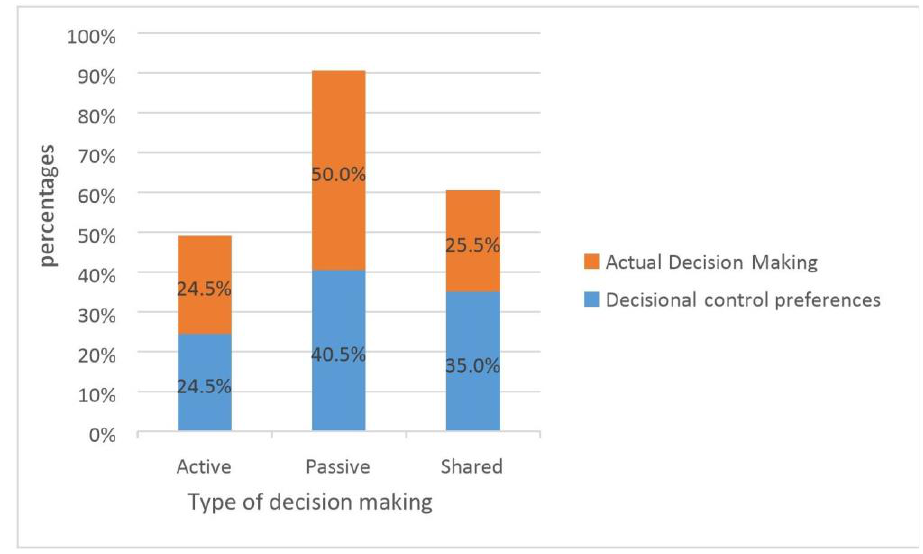
Figure 1 . Concordance between the actual decision-making and decision-control preferences.